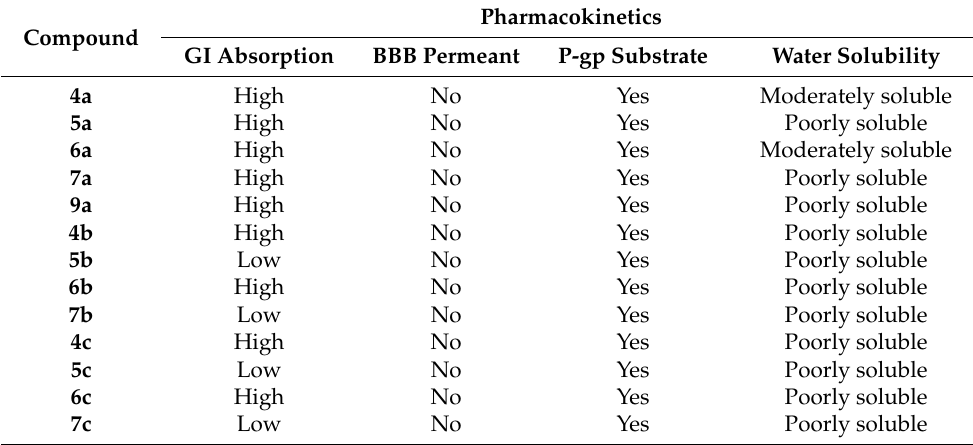
Table 10. Predicted ADME parameters of studied compounds using SWISSADME server.